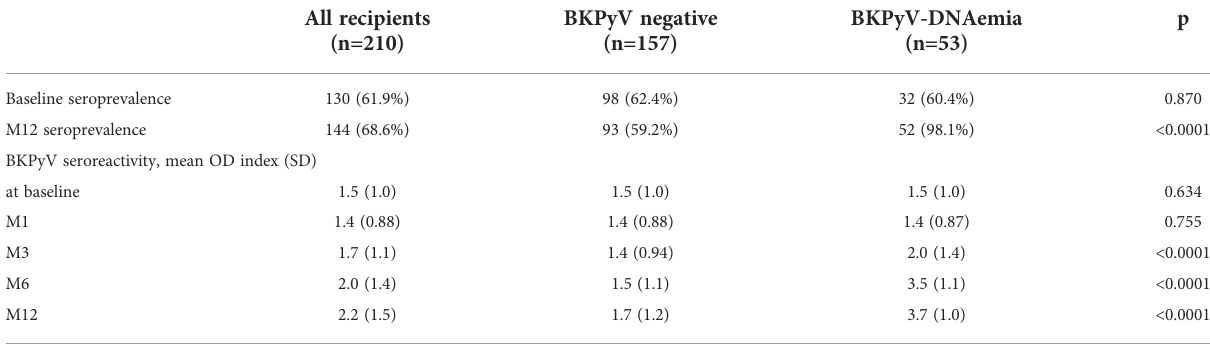
TABLE 2 BKPyV IgG seroreactivity represented by the mean OD index at the time points of 1-year follow-up. All recipients